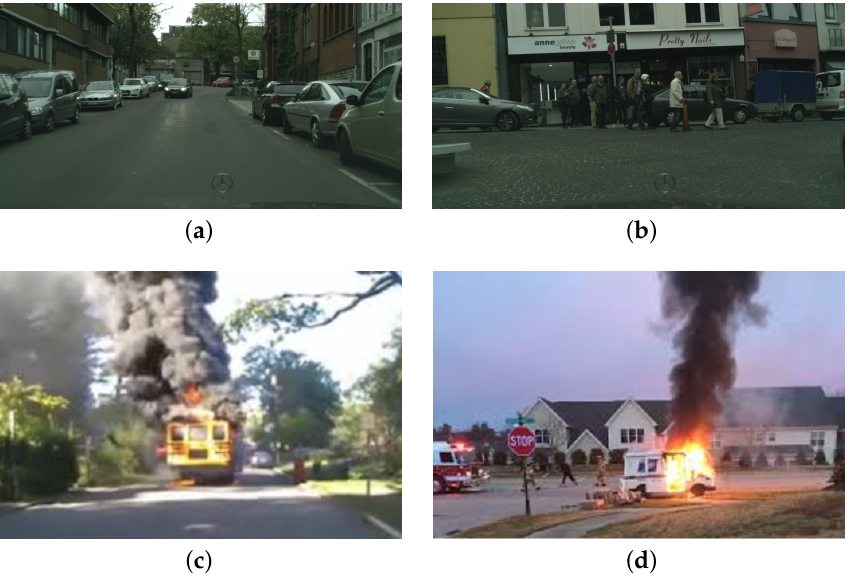
Figure 12. Examples of the images exploited for the assessment of VSU performances: ( a ) comes from [86] and represents a TN; ( b ) comes from [86] and represents a FP; ( c ) comes from [85] and represents a FN; ( d ) comes from [85] and represents a TP.